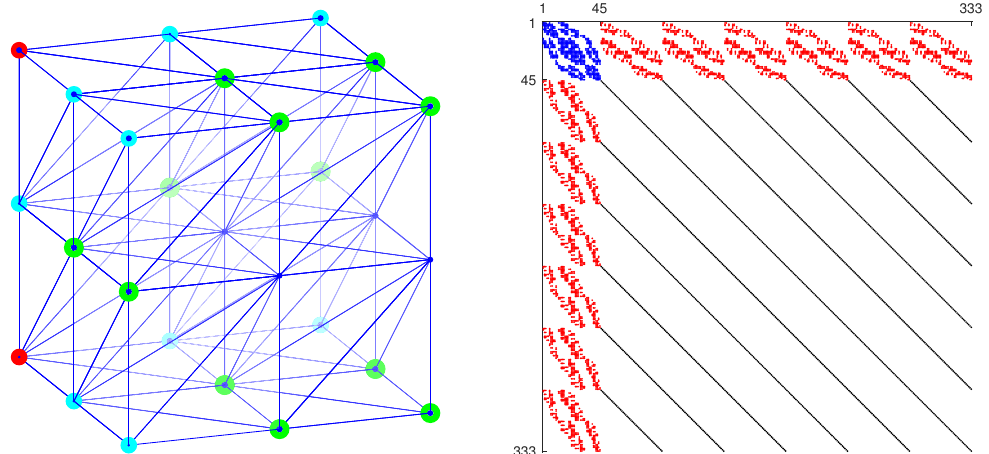
Figure 1. An illustrative triangulation of a cubic domain (see Examples 1 and 2 in Section 4) with nodes with restricted displacement marked by circles ( left ) and the corresponding sparsity pattern of the Hessian matrix ( right ). See text for details.